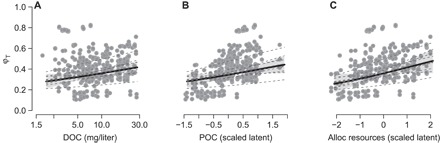
ϕT increases with t-OM.Specifically, ϕT increased with the estimated availability of DOC (A), POC (B), and their summed contribution toward allochthonous (alloc) resources (C). Points are mean estimated ϕT values for each of the 409 consumer observations with corresponding water chemistry measurements. The solid line denotes the mean increase across all consumers at mean levels of all other water chemistry variables, with the shaded polygon denoting 95% CI and dotted lines denoting consumer-specific responses.